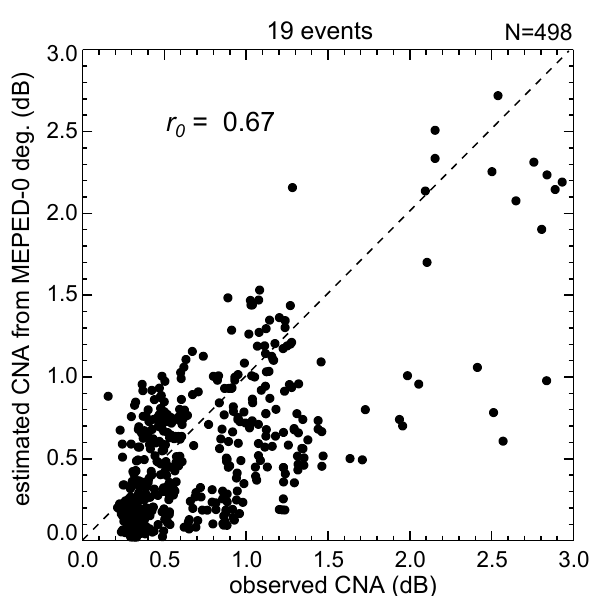
Fig. 4. Scatter plot of CNA estimated from precipitating flux mea- sured by NOAA 12 versus CNA observed with imaging riometer for all 19 events. Each dot corresponds to the CNA sampled every 2s for each event. The dashed line shows the ideal regression line, on which the estimated CNA equals the observed